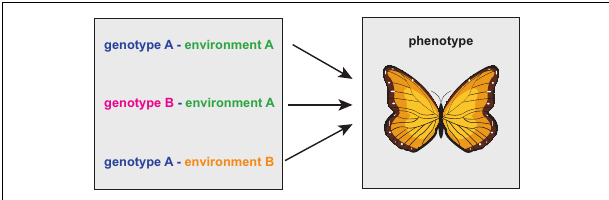
FIGURE 1 | Schematic visualization of a situation when three different genotype-environment constellations lead to the same phenotype. Here it is important to note that the similarity of the three genotype-environment configurations can only be judged on the phenotype level of the